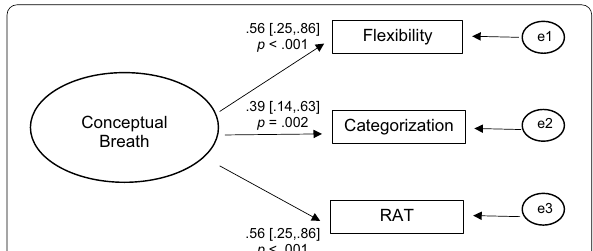
Fig. 1 Results from the measurement model for the latent cognitive breadth factor. Note. The large oval represents the latent conceptual breadth factor; small ovals represent residual error variances. Rectangles are measured variables. Flexibility Alternative Uses = Task; Categorization Object Categorization Task; RAT Remote = = Associates Test. Standardized parameters are shown, along 95% confidence intervals and p values